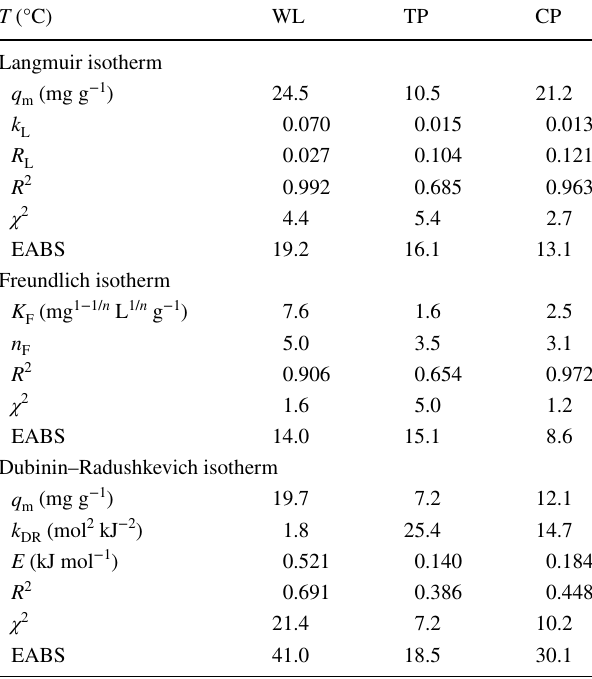
Table 3 Parameters of the Langmuir, Freundlich and D–R isotherm models